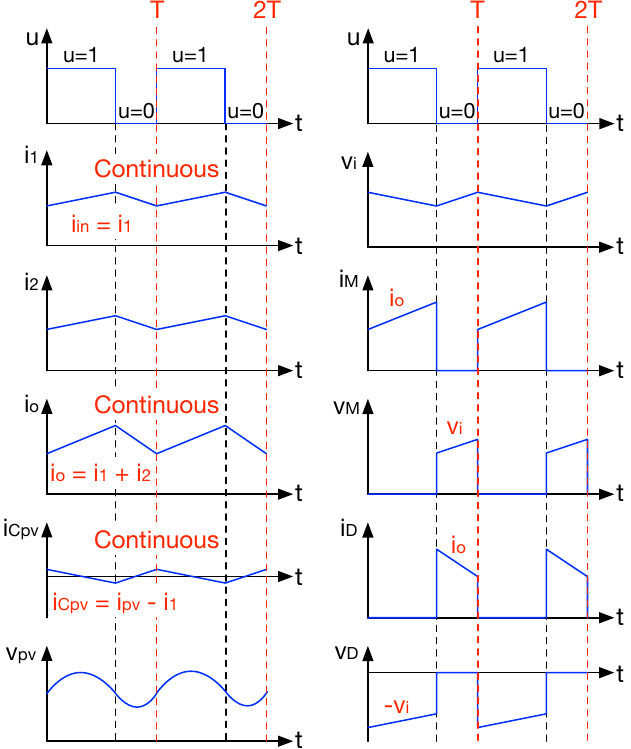
Figure 4. Waveforms of the PV system based on the CIOC buck